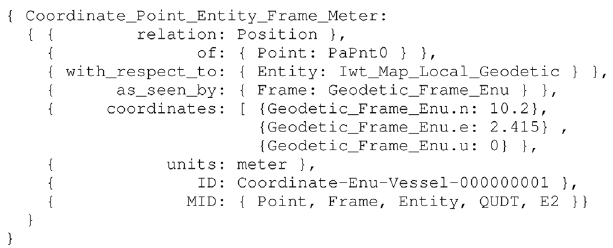
Frontiers in Robotics and AI |